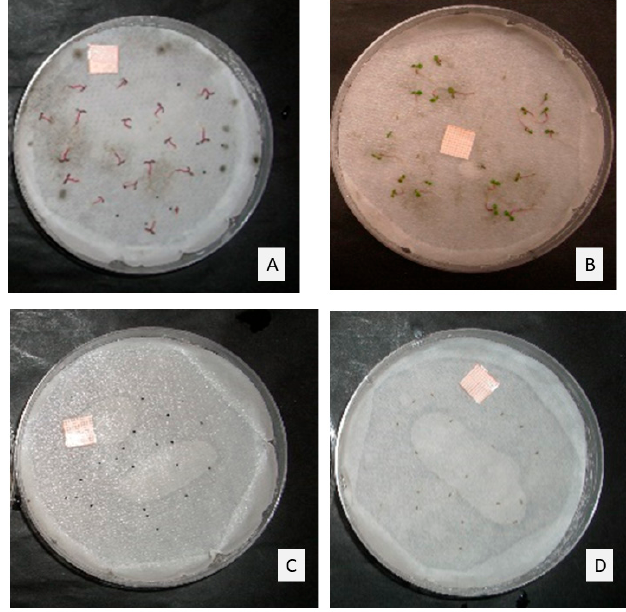
Figure 2. Seeds in control plates of ( A ) Portulaca oleracea , and ( B ) Erigeron canadensis , and seeds treated with the maximum doses of TC1 (1 µ L / mL) of ( C ) P. oleracea , and ( D ) E. canadensis , after 14-days incubation.